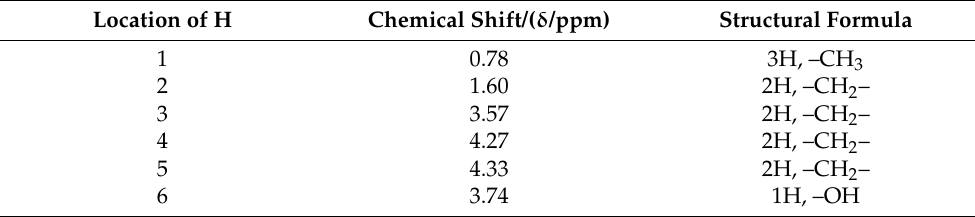
Table 1. Analytical table of the 1 H-NMR spectrum for the 3-ethyl-3-hydroxymethyloxetane. Location of H Chemical Shift/( δ /ppm) Structural